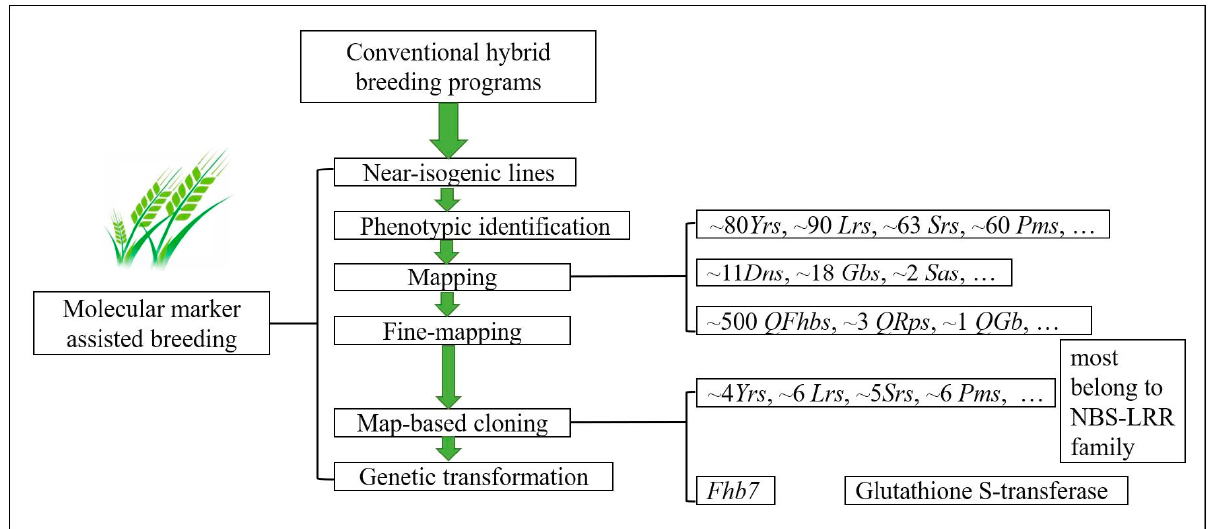
Figure 1. The regular flow charts of molecular marker-assisted breeding programs involved in wheat cultivar improvements against biotic stresses. The near-isogenic lines developed from conventional hybrid breeding programs were employed for identification and mapping the resistance genes by adopting the diverse molecular markers, and many dominant genes and QTLs had been mapped on wheat chromosomes. Following that, many candidate genes or QTL allenes had been isolated from the wheat germplasms or its donor species with map-based cloning. Most wheat resistance genes belong to the NBS-LRR family, with the Fhb7 gene encoding a protein with Glutathione S-transferase. Yrs , stripe rust resistance genes; Lrs , leaf rust resistance genes; Sr , stem rust resistance genes; Pms , powdery mildew resistance genes; Dns , Russian wheat aphid Diuraphis noxia resistance genes; Gbs , greenbug Schizaphis graminum resistance genes; Sas , English grain aphid Sitobion avenae resistance genes; QFhbs , scab resistance QTLs; QRps , bird cherry-oat aphid Rhopalosiphum padi resistance QTLs; QGb , greenbug resistance QTL.